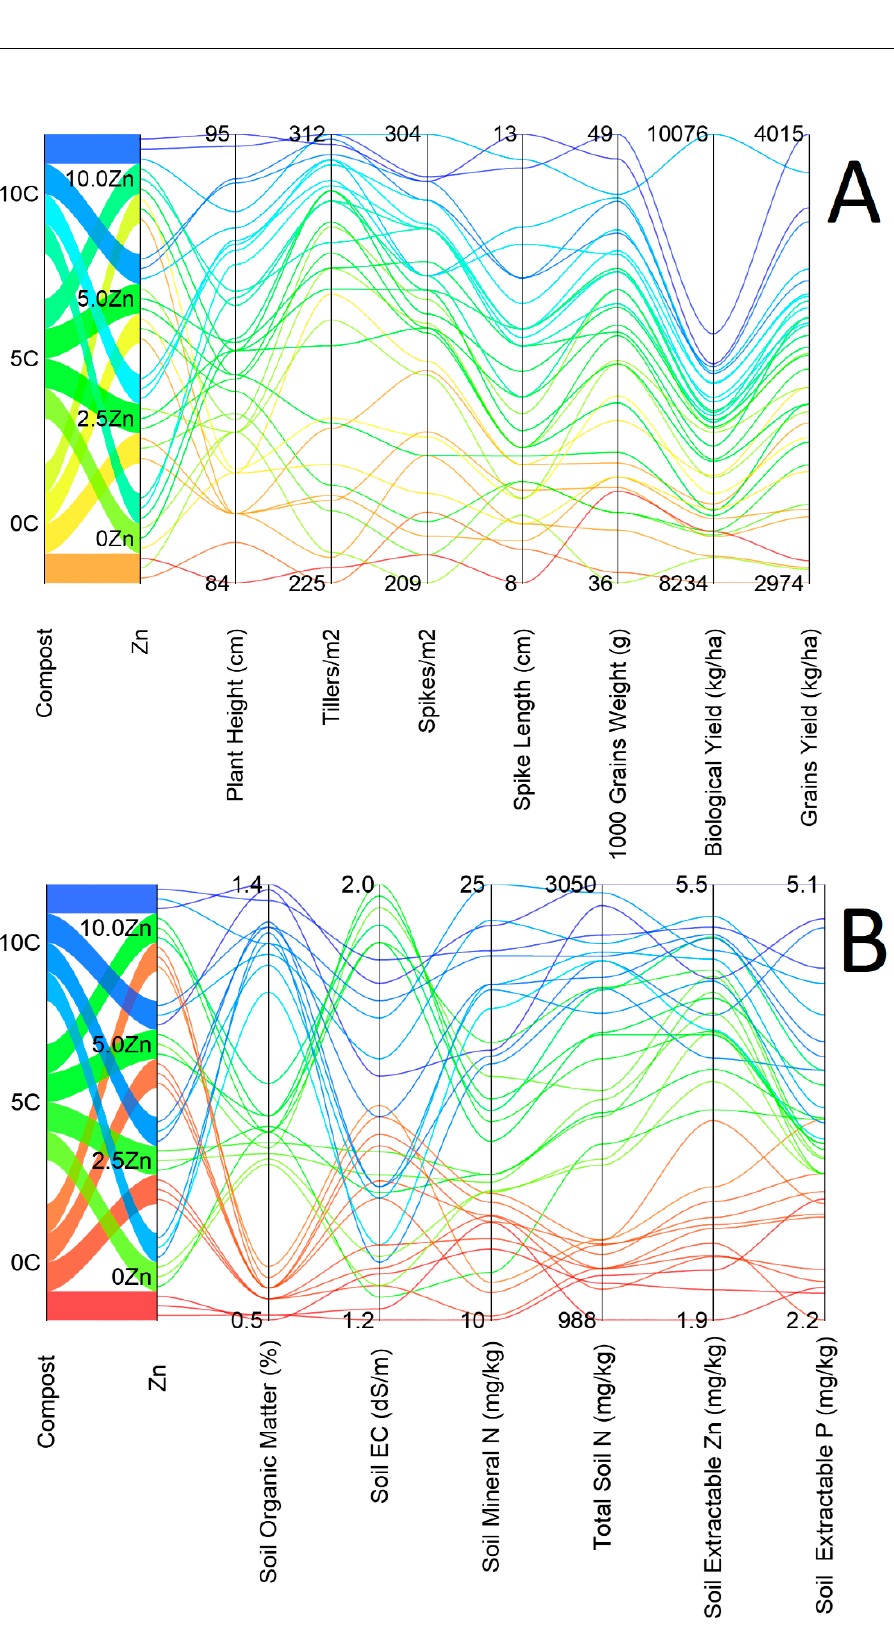
Figure 7. Parallel plots showing data range for the studied plant ( A ) and soil attributes ( B ) in the context of Zn–compost interaction. All the values indicate data ranges; i.e., the highest and lowest values of the studied attributes in the context of Zn and compost application